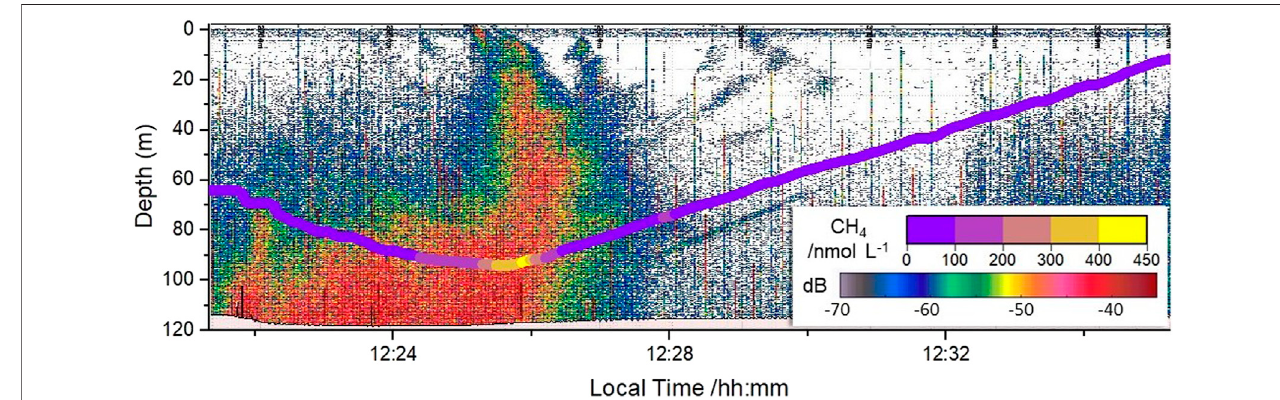
FIGURE 2 | Qualitative comparison between the time series from the continuous concentration of dissolved methane measured by MILS (colored line) and the acoustic signal from the echosounder (colored background). The data are plotted against local time. The data are from the VP03 pro fi le performed on April 5th at the deeper site (44.224 ° N, 30.730 °